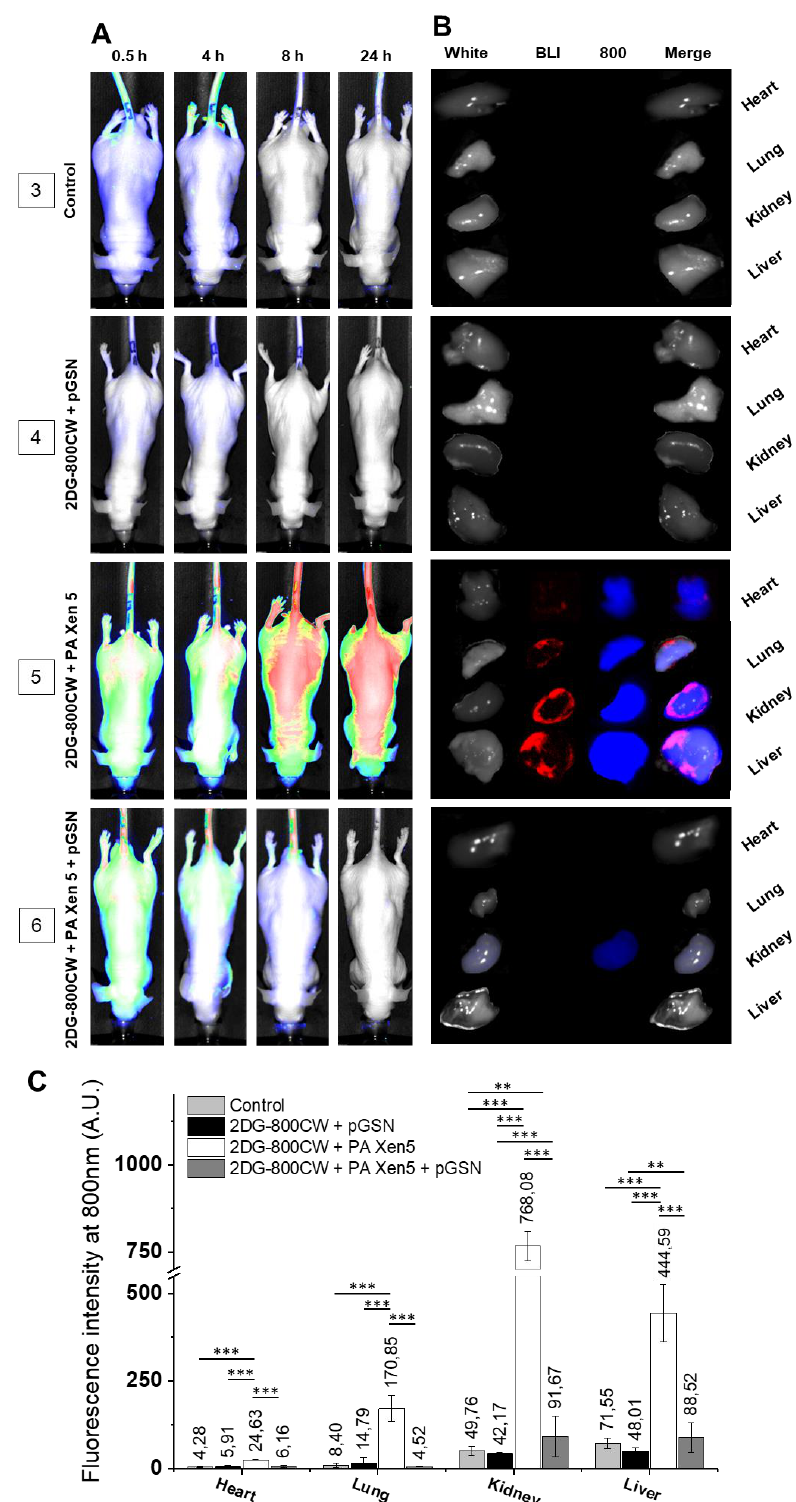
Figure 2. Visualization of systemic inflammation in vivo using analysis of IRDye ® 800CW 2-deoxy-D-glucose (2DG-800CW) fluorescence. 2DG-800CW was injected at the dose of 10 µM to non-infected, control animals (group 3); healthy animals were injected with pGSN at the dose of 40 mg/kg (group 4); PA Xen5-infected, non-treated animals (group 5) and PA Xen5-infected animals were treated with pGSN at the dose of 40 mg/kg (group 6). At the start of the experiment, mice were injected intravenously with sterile saline (groups 3 and 4) or PA Xen5 inoculum (groups 5 and 6). Eight hours later, 2DG-800 CW at the dose of 10 µM was injected to all tested animals, followed by administration